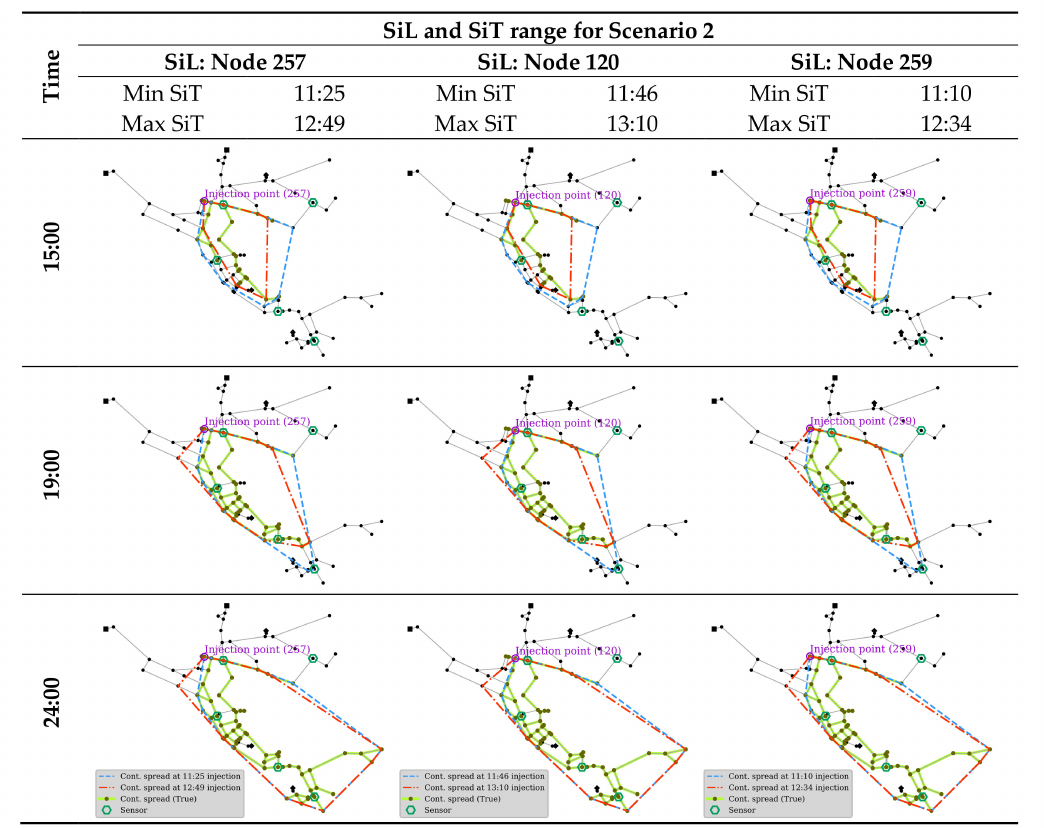
Figure 15. Spatiotemporal contamination extent by three contamination settings found in Scenario